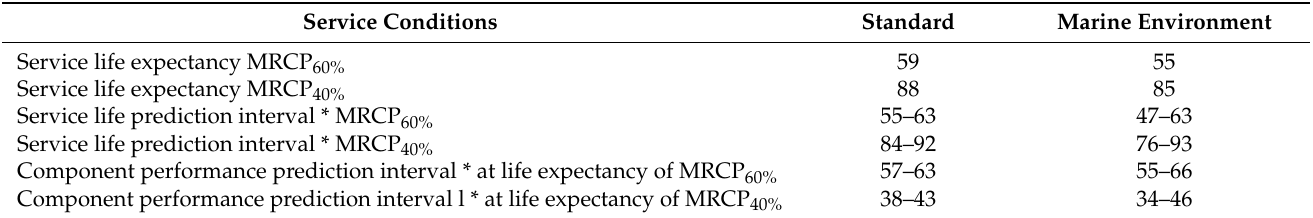
Table 7. Service life expectancy, PSLI, and component performance prediction interval, PCPI, of exterior dry-fixed stone claddings.